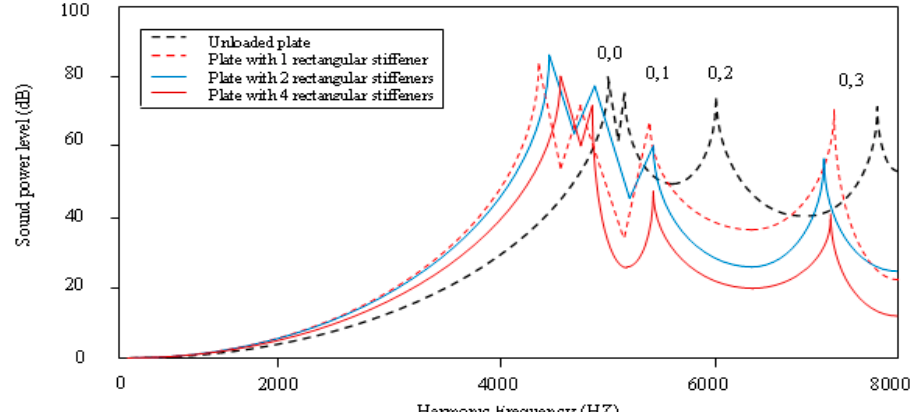
Figure 17. Numerical comparison of sound power level for annular plate having parabolic decreasing increasing thickness variation (Case II) for different attachments of rectangular stiffener patches for taper ratio T x = 0.75.